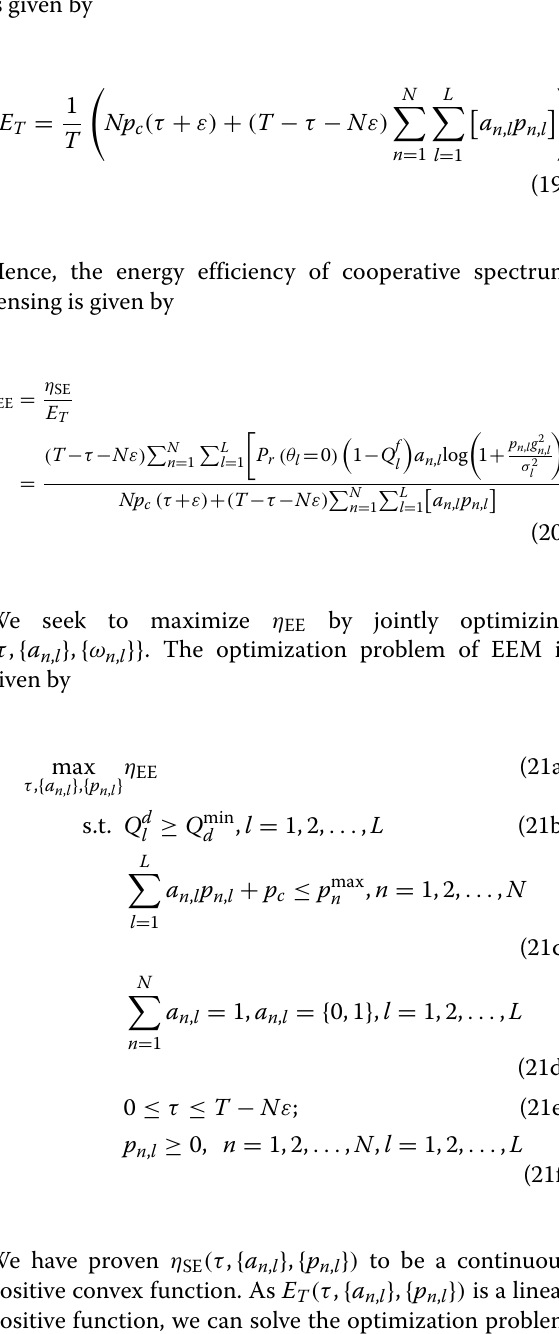
Fig. 2 Spectrum efficiency with sensing